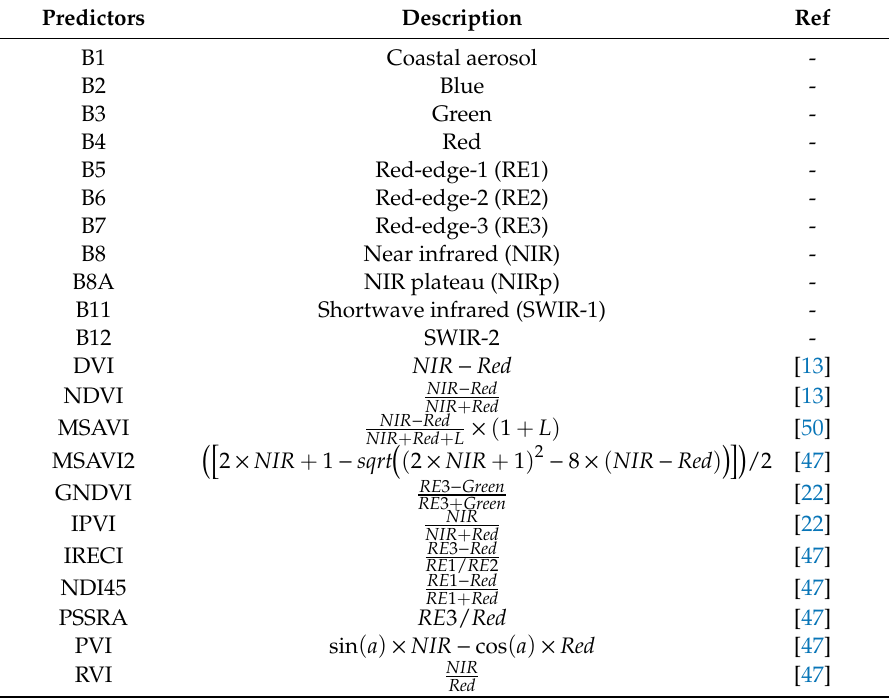
Table 3. The variables and predictors: Sentinel-2 bands, vegetation and soil indices, elevation derivatives, equations, and